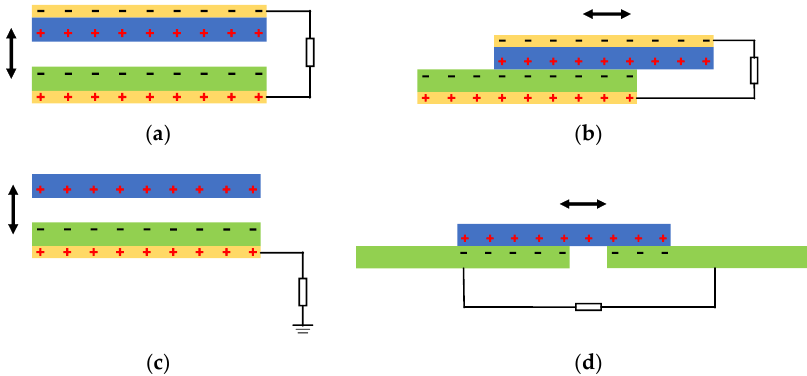
Figure 11. Working mode of triboelectric generators: ( a ) contact mode; ( b ) sliding mode; ( c ) single- electrode mode; and ( d ) freestanding mode.